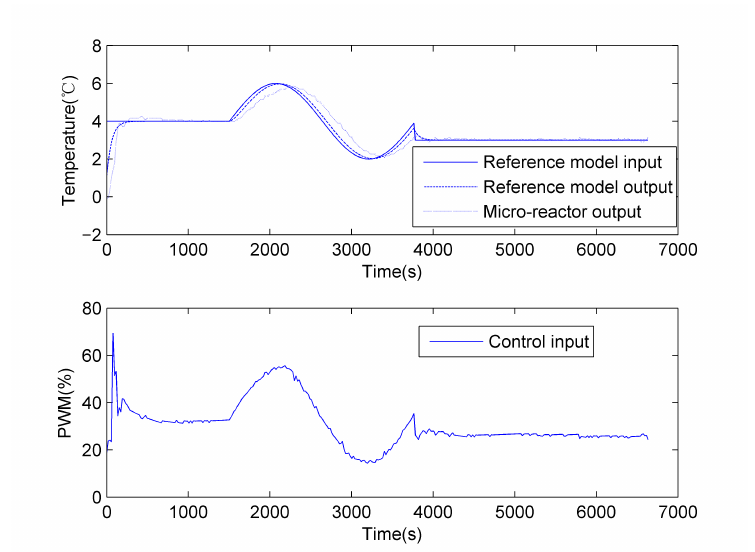
Figure 14. Experimental results of the proposed method.